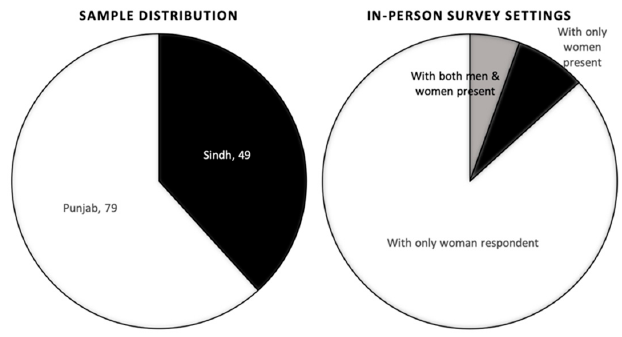
Figure 3. Sample distribution and in-person survey settings of gender survey (survey two).